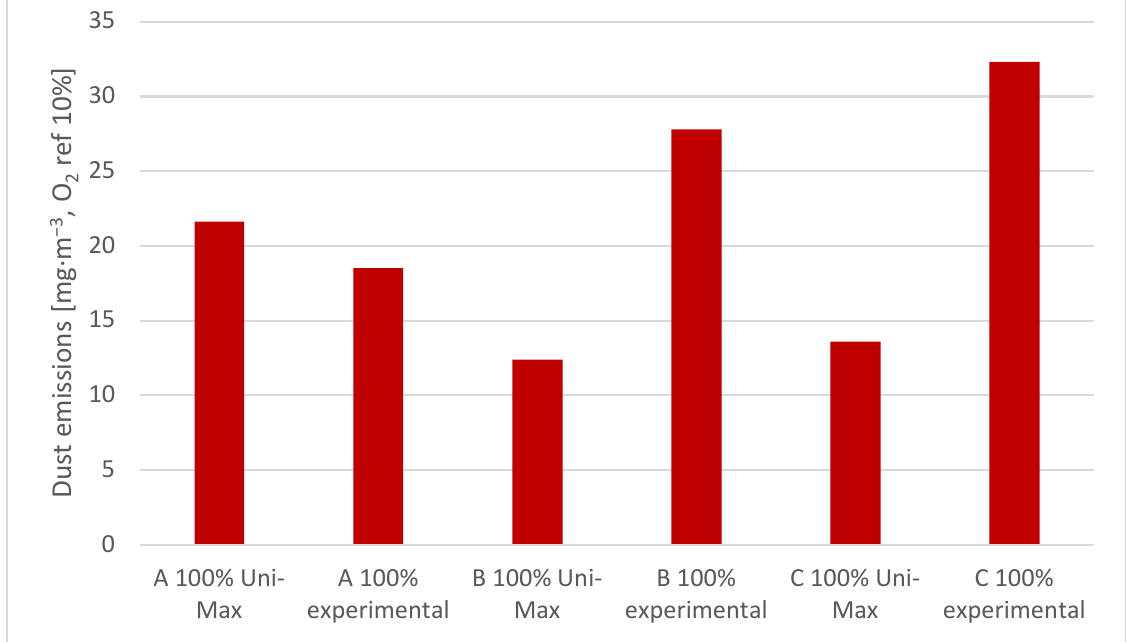
Figure 9. Comparison of average statistical dust emissions from the combustion of three types of wood pellets in two different burners at full load.